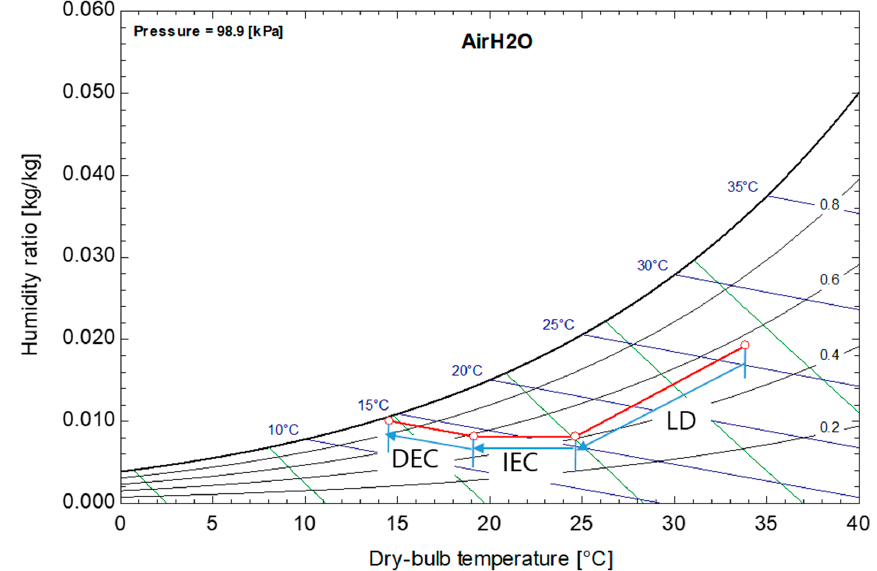
Figure 2. Conditions of the process air with the LDIDECOAS.